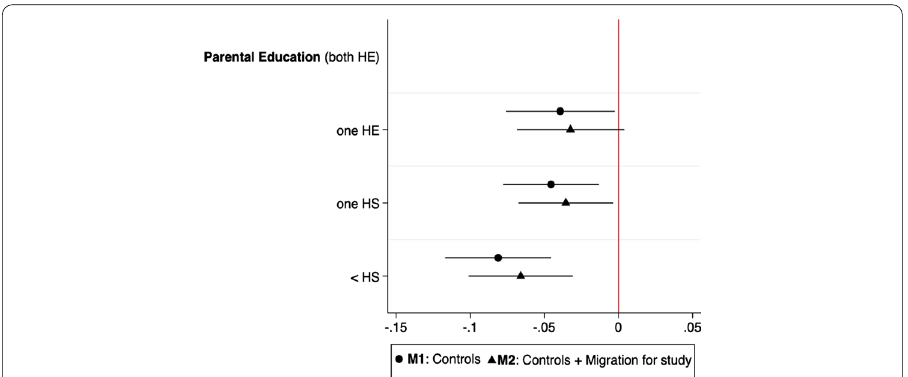
Fig. 4 Marginal change in predicted income as a function of parental education. Bars denote 95% confidence intervals; both HE parent with a higher education degree; one HS with less than a high school